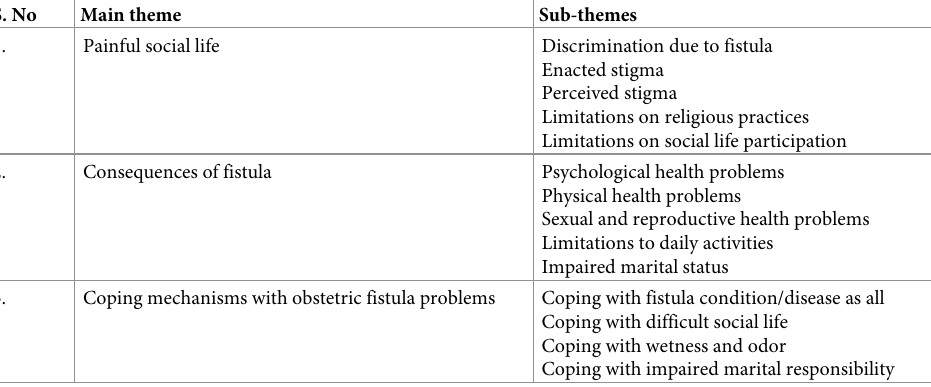
Table 3. Themes of challenges and coping mechanisms among women with obstetric fistula in Ethiopia, April to August 2019 (n = 14). S.